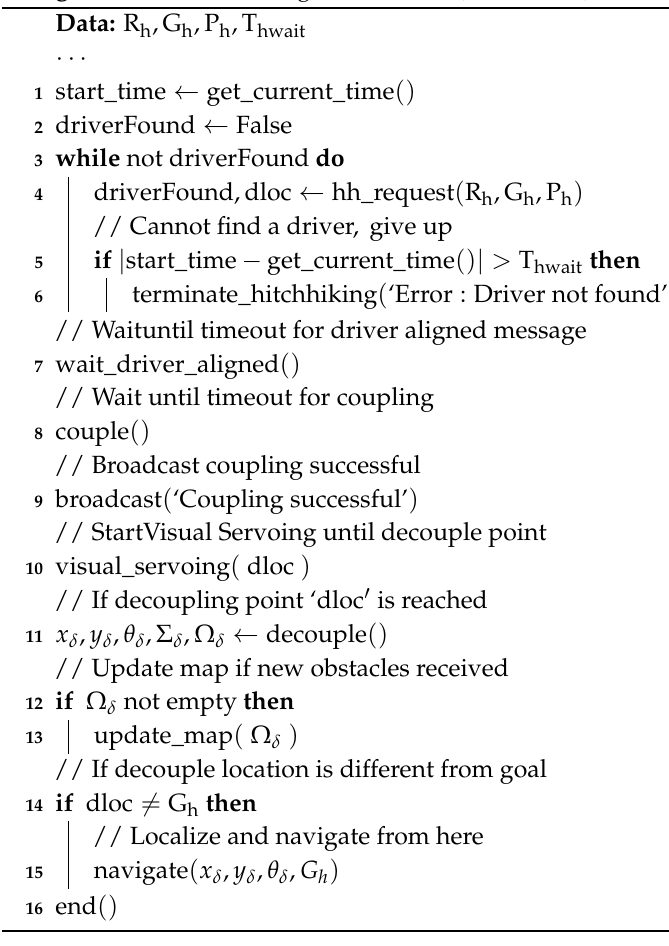
Algorithm 2: Hitchhiking Pseudocode